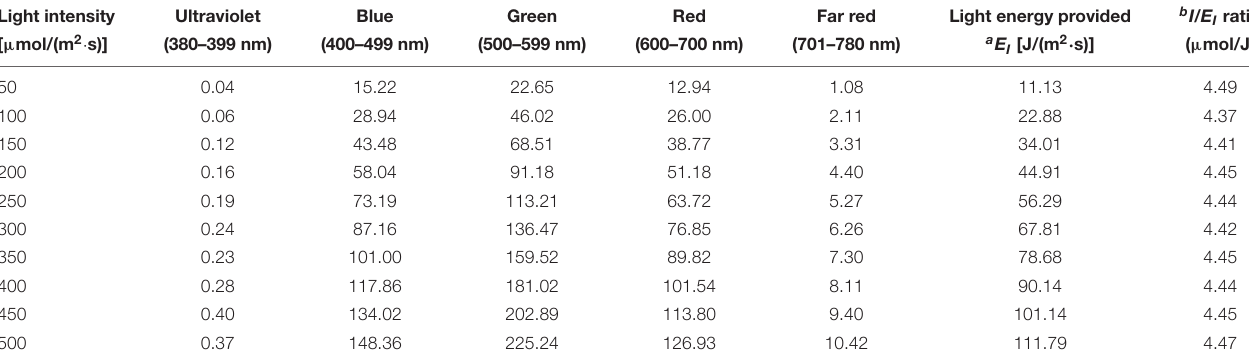
TABLE 1 | Illumination conditions and white light emitting diode (LED) spectrum properties applied in this study. Light intensity Ultraviolet Blue Green Red Far red Light energy provided b I / E I